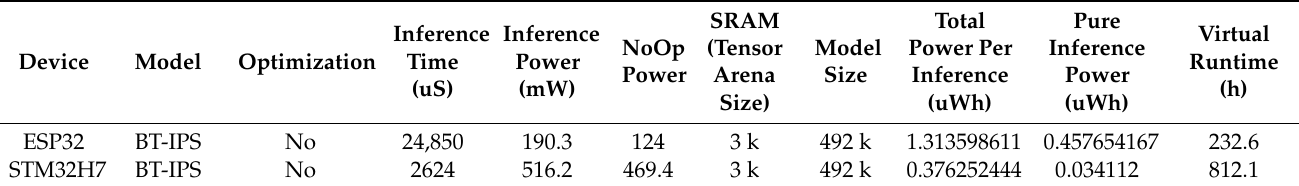
Table 4. BlueTooth IPS Model